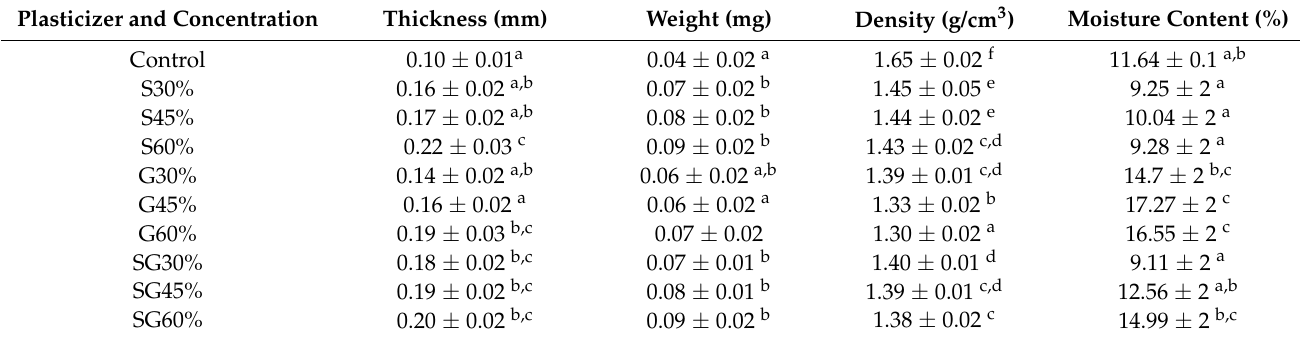
Table 2. Physical properties of corn starch films incorporated with various plasticizer types and concentration. Plasticizer and